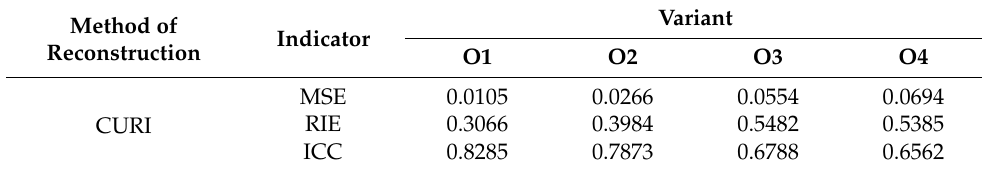
Table 2. Image reconstruction indicators—CURI